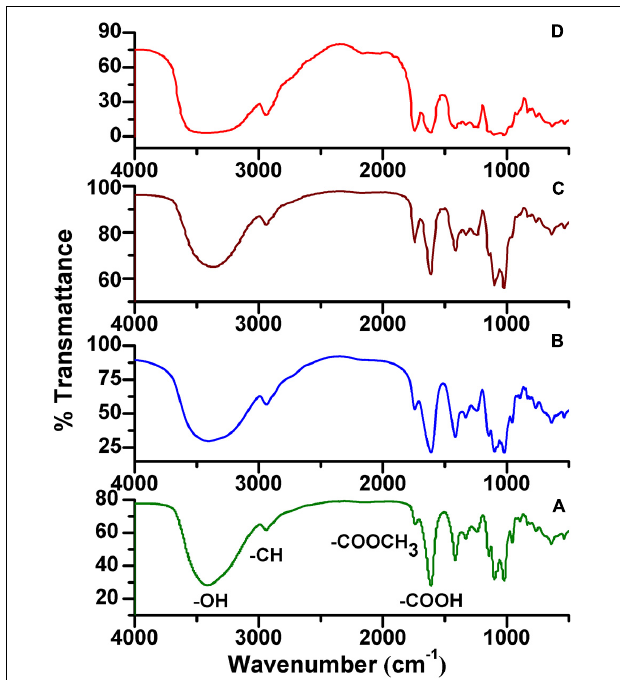
FIGURE 3 | Fourier transform-infrared spectroscopy (FT-IR) spectra of HG pectins from plants. (A) HG-PN-2 (Class I); (B) HG-PJ-1 (Class II); (C) HG-CC-1 (Class III); and (D) HG-KL-1 (Class IV).